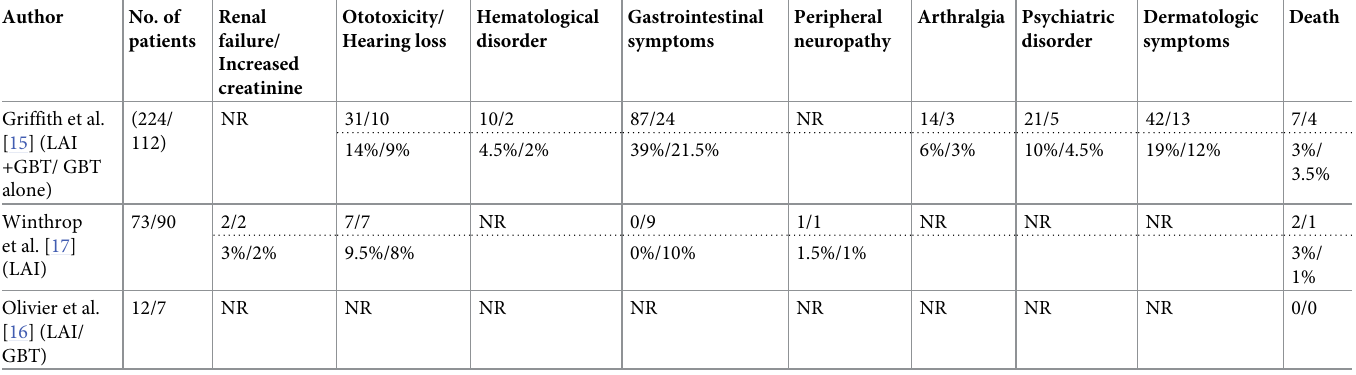
Table 6. Adverse effects in experimental